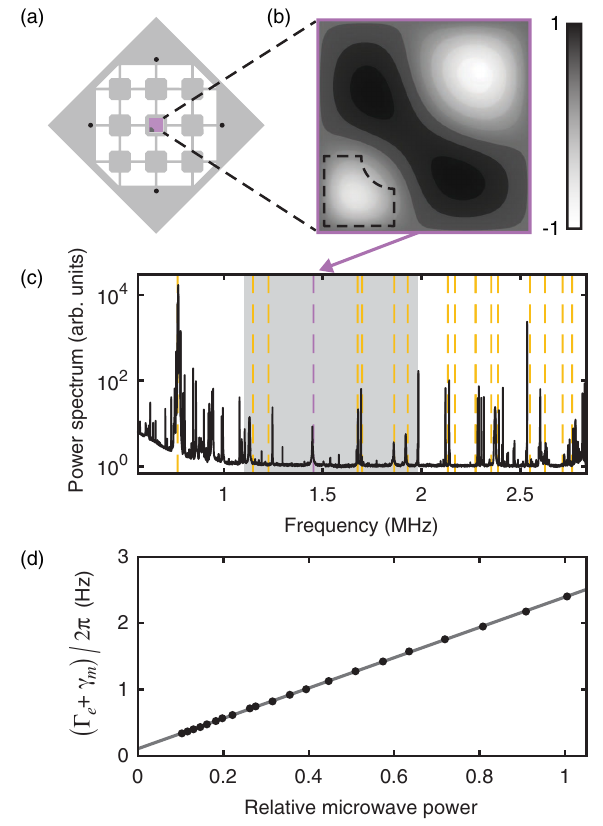
FIG. 6. Mechanical design and characterization. (a) Phononic shield design. Black circles (not to scale) indicate location of 20 - μ m-diameter posts that determine the nominal capacitor pad separation. (b) Normalized displacement of the 1.45 MHz vibra- tional mode from finite-element simulation of the membrane and capacitor pad (dashed line). (c) Optically measured mechanical spectrum. The shaded region indicates the band gap obtained from a simulation with periodic boundary conditions. Expected frequencies of membrane modes (dashed lines) are obtained from finite-element simulation. (d) Total damping obtained from electromechanical ringdown measurements versus microwave pump power. Extrapolation to zero pump power yields an = 2 π ¼ 108 intrinsic mechanical damping rate of γ m